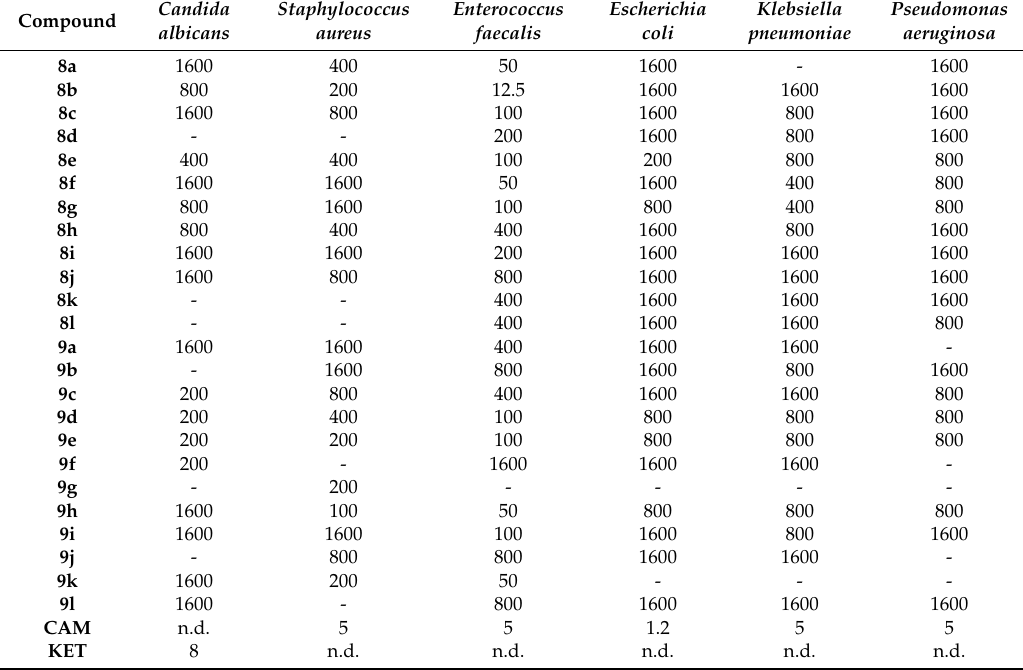
Table 3. Antimicrobial activity (MIC µ g/mL) of the synthesized compounds.